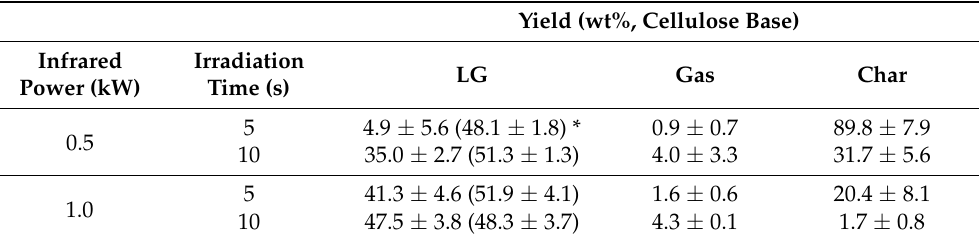
Table 1. Yields of LG, gas and char from the pyrolysis of Whatman cellulose while varying the IR power and irradiation time with a 5 L/min nitrogen flow.